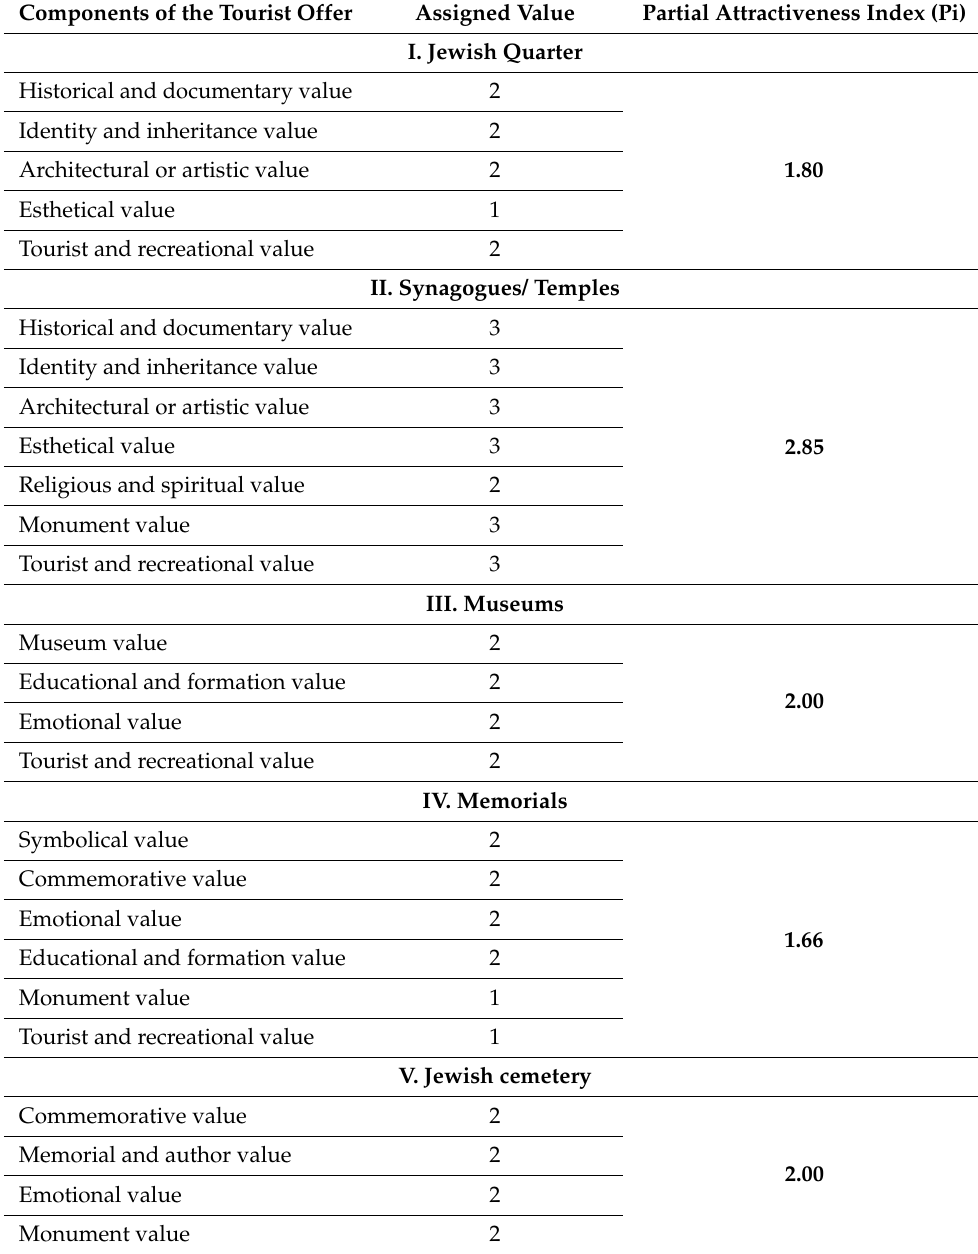
Table 1. Evaluation of the components of the tourist offer of the Jewish heritage tourism product. Components of the Tourist